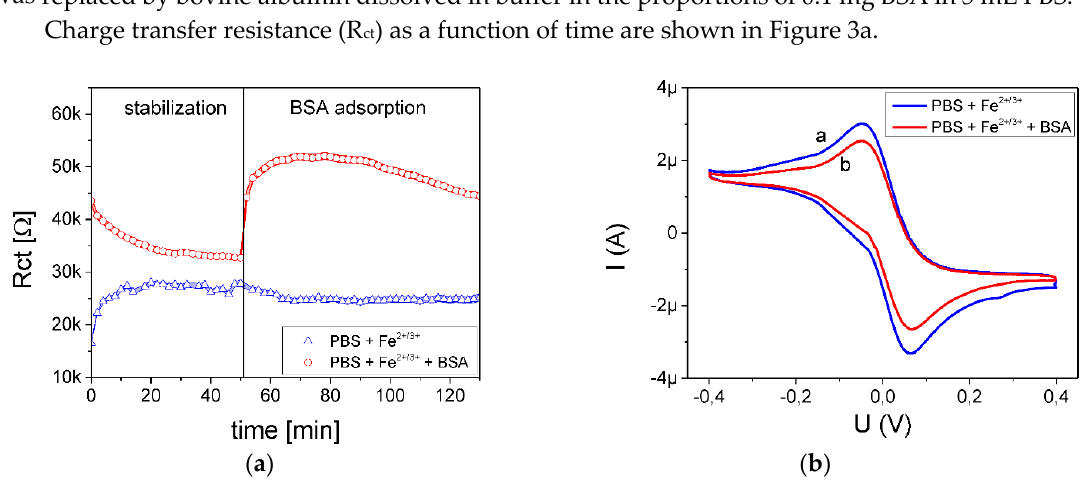
Figure 3. ( a ) Transfer charge resistance (Rct) as a function of time ( b ) Cyclic voltammograms recorded in a 0.5 mM Fe 2+/3+ + PBS solution after different step of modification, ( a ) bare Au WE, ( b ) BSA adsorption on WE